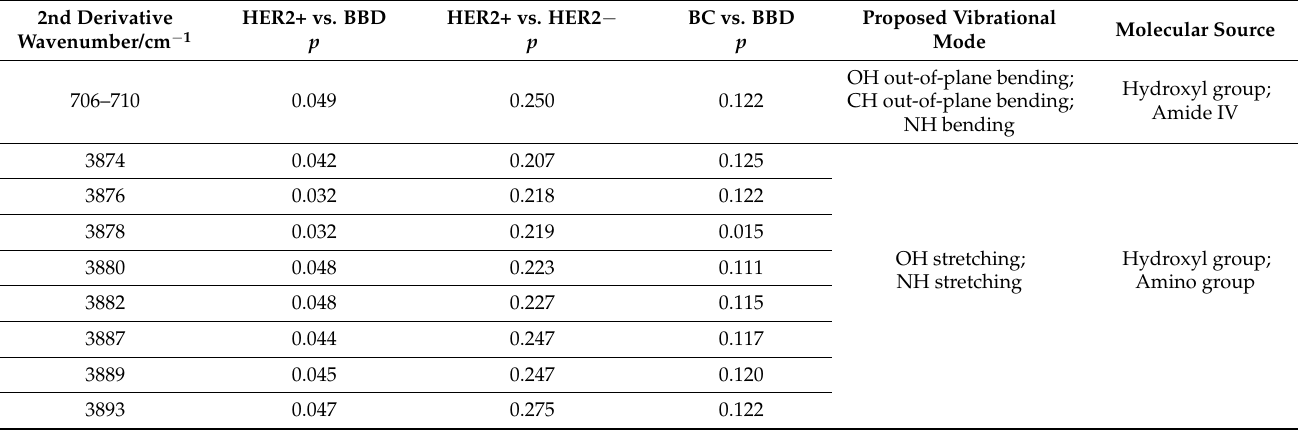
Table 2. Assignments and comparison between second derivative serological ATR-FTIR spectra of women with HER2+ BC ( n = 6), HER2 − BC ( n = 11) and women with BBD ( n = 8).